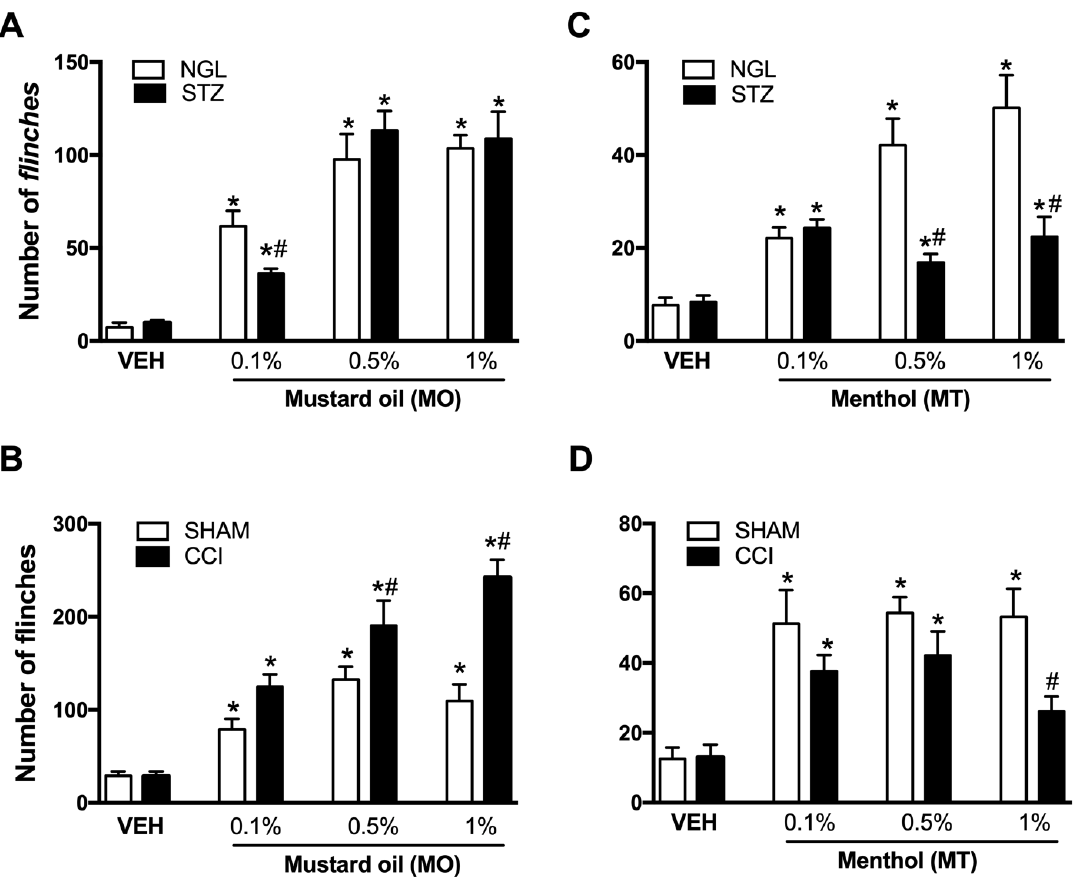
FIGURE 4 - Direct nociceptive response to intraplantar (ipl) injection of TRPA1 and TRPM8 agonists, mustard oil (MO) and menthol (MT), respectively, in (A, C) diabetic and (B, D) CCI rats. Bars represent the total number of flinches evoked after ipl injection of 50μL of MO or MT (0.1, 0.5 or 1%) in STZ or CCI rats, as well as their control and vehicle-treated groups. Values represent mean ± SEM. *indicates p<0.05 when compared to the respective group treated with vehicle (VEH; corn oil). # indicates p<0.05 when STZ or CCI groups were compared with their control groups, NGL or SHAM, treated with the same concentration of either MT or MO. One-way ANOVA followed by Newman-Keuls’ post hoc